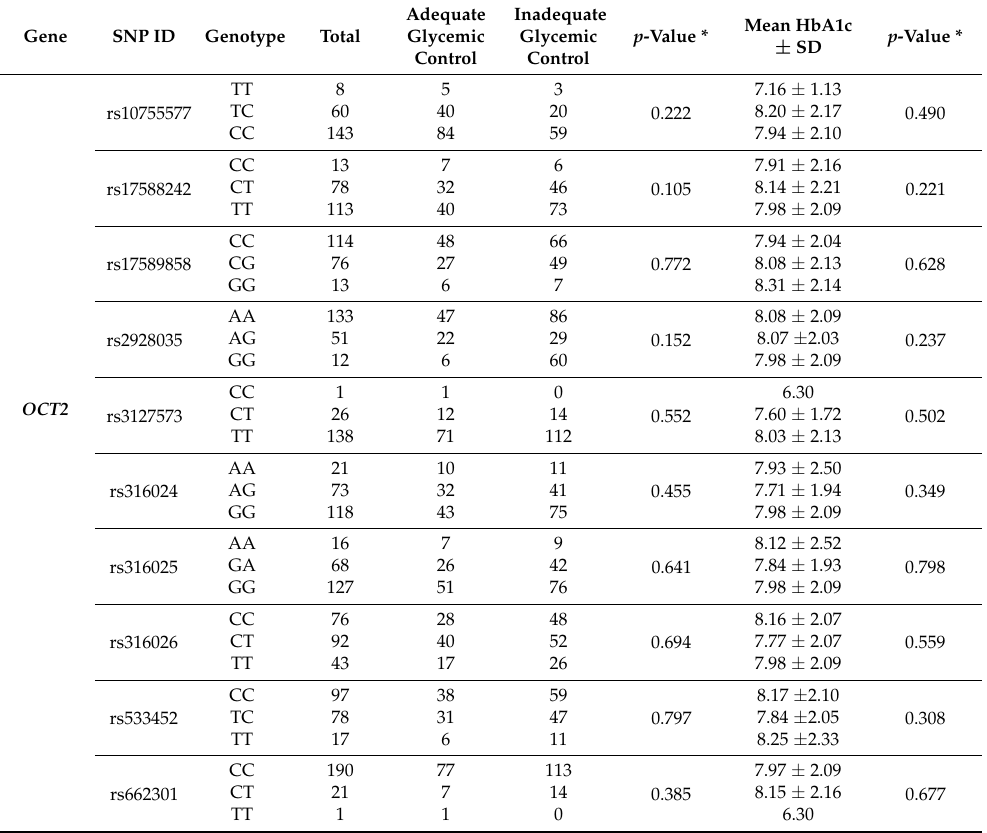
Table 5. Effect of genotype distribution of studied SNPs for OCT2 gene on glycemic control and on HbA1c level in Jordanian T2DM patients receiving